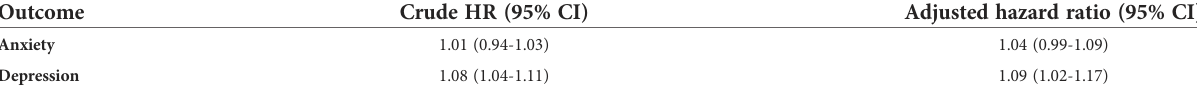
Adjusted for age, occupation, income, urbanization, and CCI